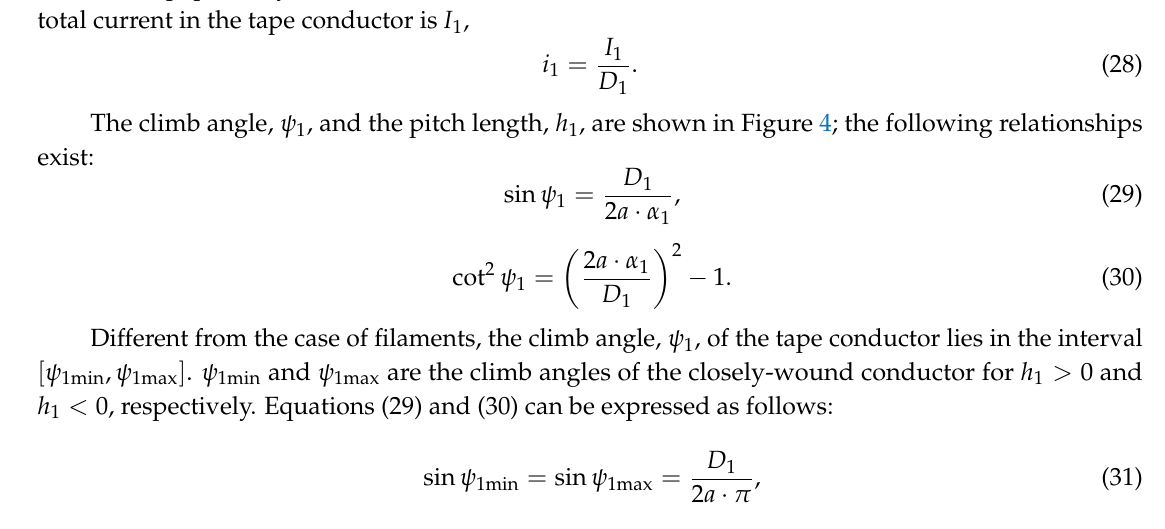
Figure 4. Lateral surface of coil-1 in Figure 3.